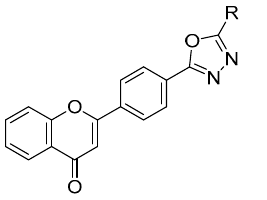
Figure 1. Structure of the basic skeleton of the chromen-4-one based oxadiazole derivatives 1 – 19.